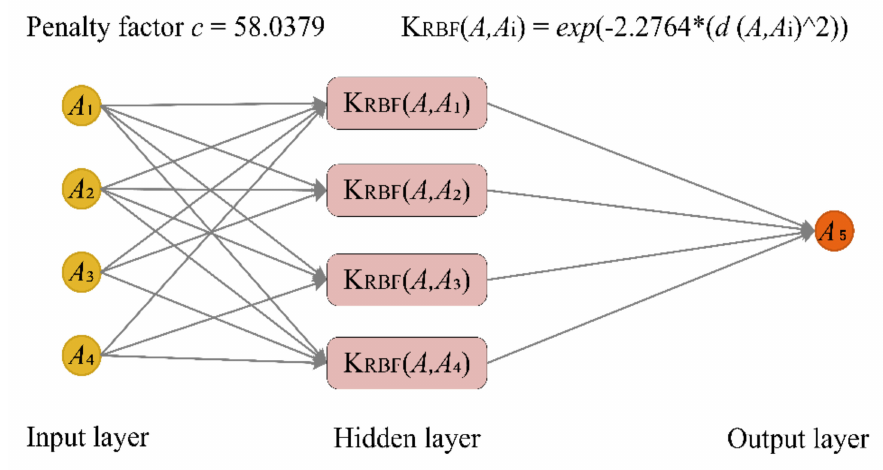
Figure 14. Structure of SSA-SVR model.